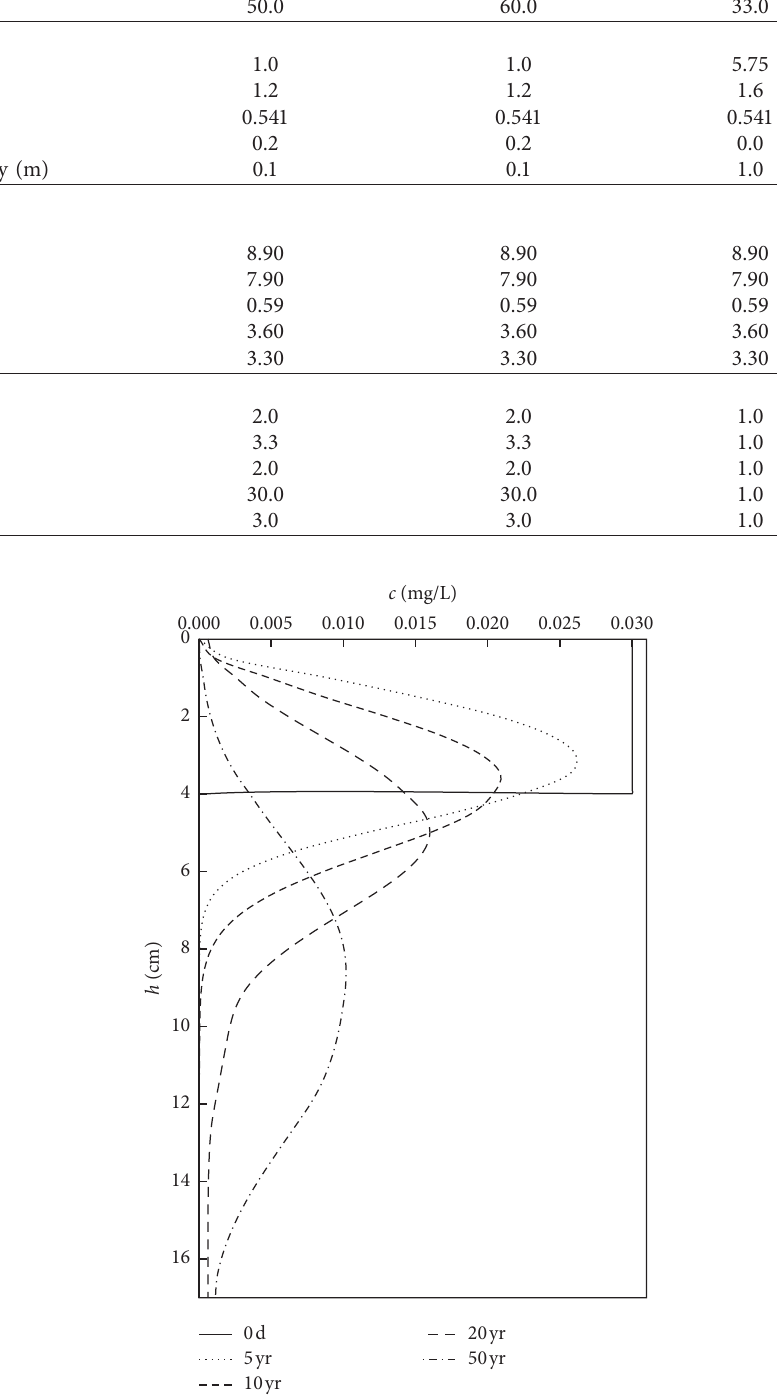
Figure 5: Variation of Cd concentration distribution with